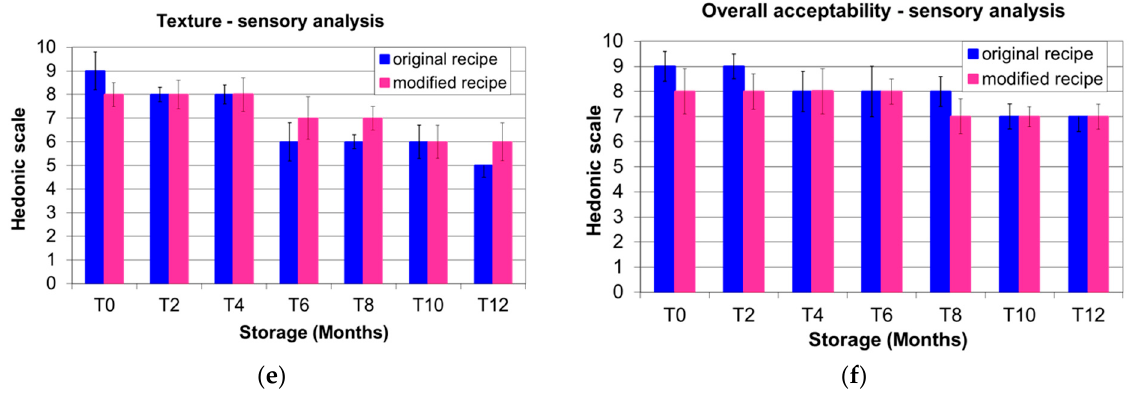
Figure 3. Sensory analysis of Italian Cantuccini biscuits prepared with the original recipe and the modified recipe during one year’s shelf-life: ( a ) colour; ( b ) appearance; ( c ) taste; ( d ) flavour; ( e ) texture; ( f ) overall acceptability.